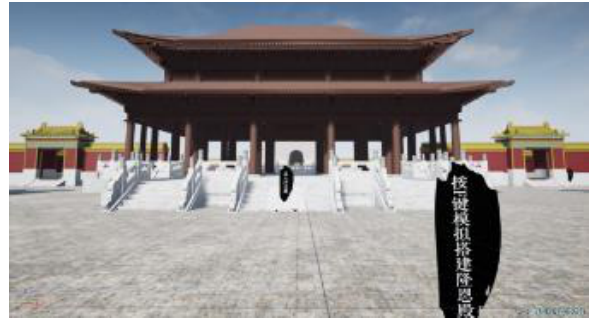
Figure 17. The animation of the reconstruction